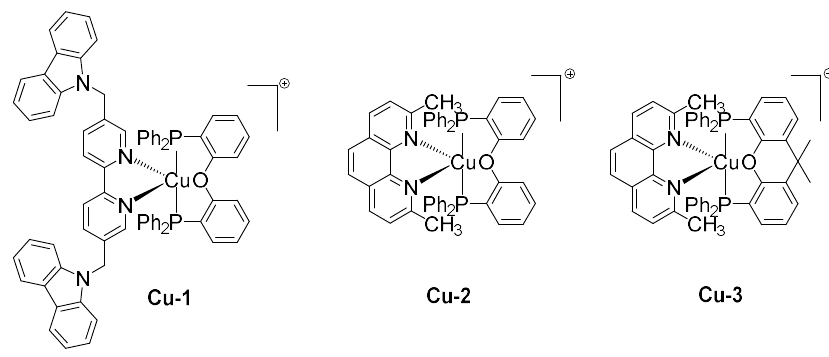
Figure 2. Chemical structures of Cu-1 – Cu-3 .